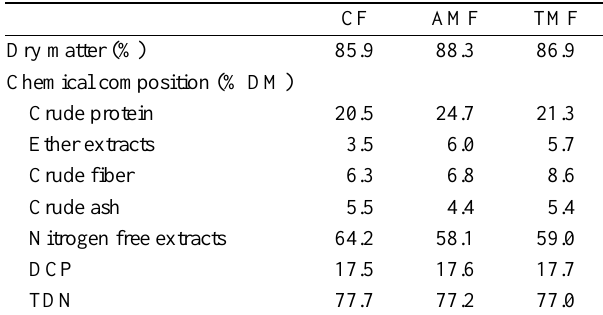
Table 4. Chemical composition of control feed (CF),